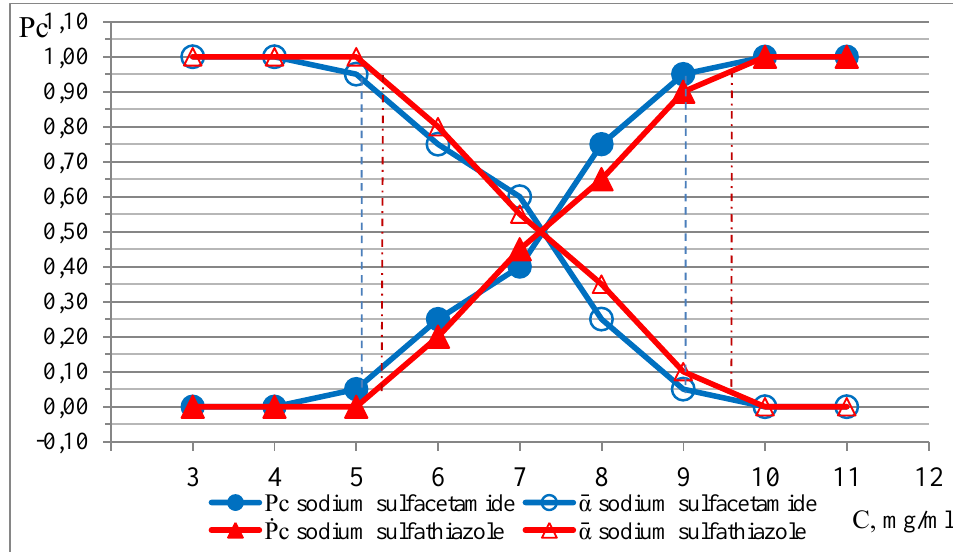
Fig. 1. The ―effectiveness curve‖ for the identification of the derivatives of sulfanilic acid amides using the test kit with